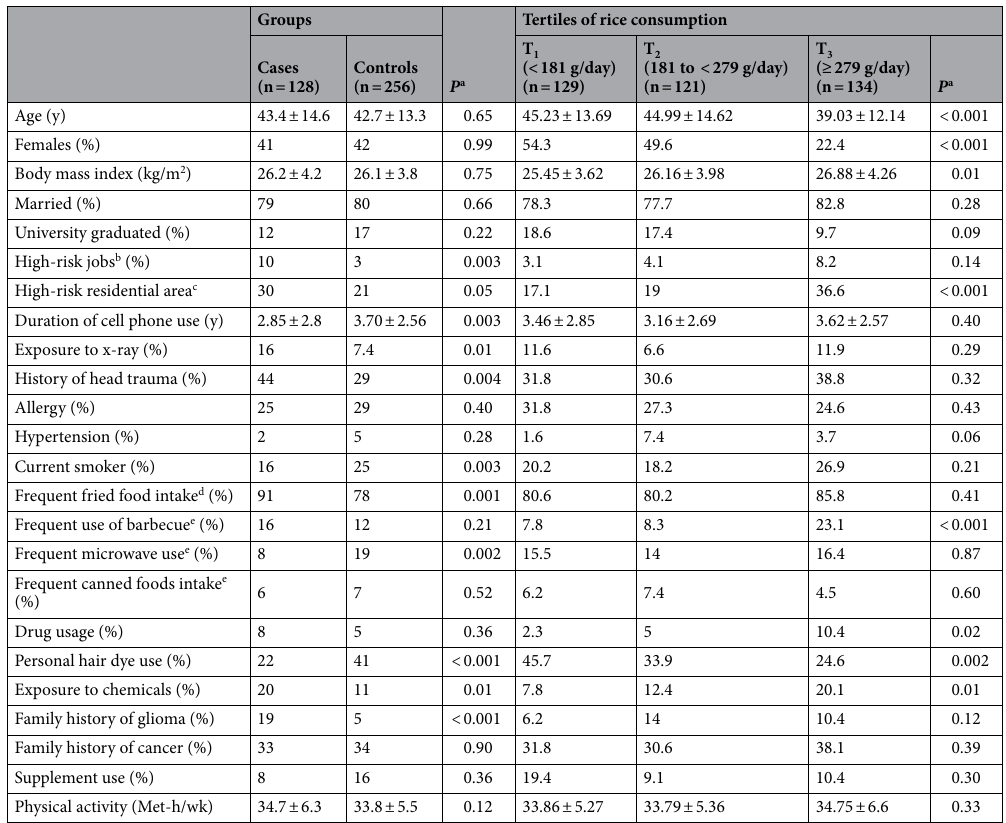
Table 1. General characteristics of study participants across tertiles of rice consumption. Data are presented as mean ± SD or percent. a Obtained from one-way ANOVA, independent samples Student’s t test or chi-square test, were appropriate. b Farmers were considered as having a high-risk occupation. c Individuals who lived in places near to the electromagnetic fields, cell phone and broadcast antennas in the last 10 years were defined as living in high-risk areas. d Individuals with at least two times of fried food intake per week were considered as frequent fried food users. e Those with at least two times per week of barbeque use, microwave use as well as consumption of canned foods were considered as frequent